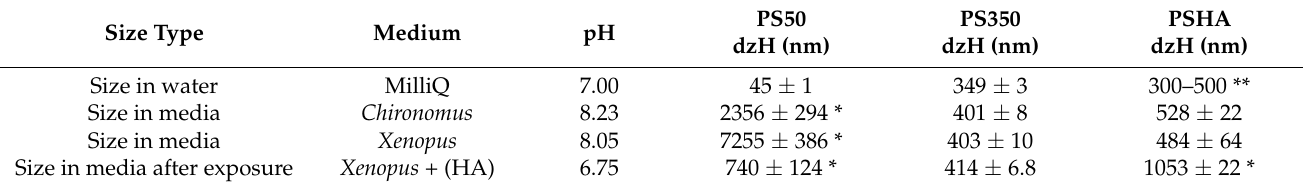
Table 2. Size of the particles in the Xenopus and Chironomus exposure media (10 mg L − 1 ).